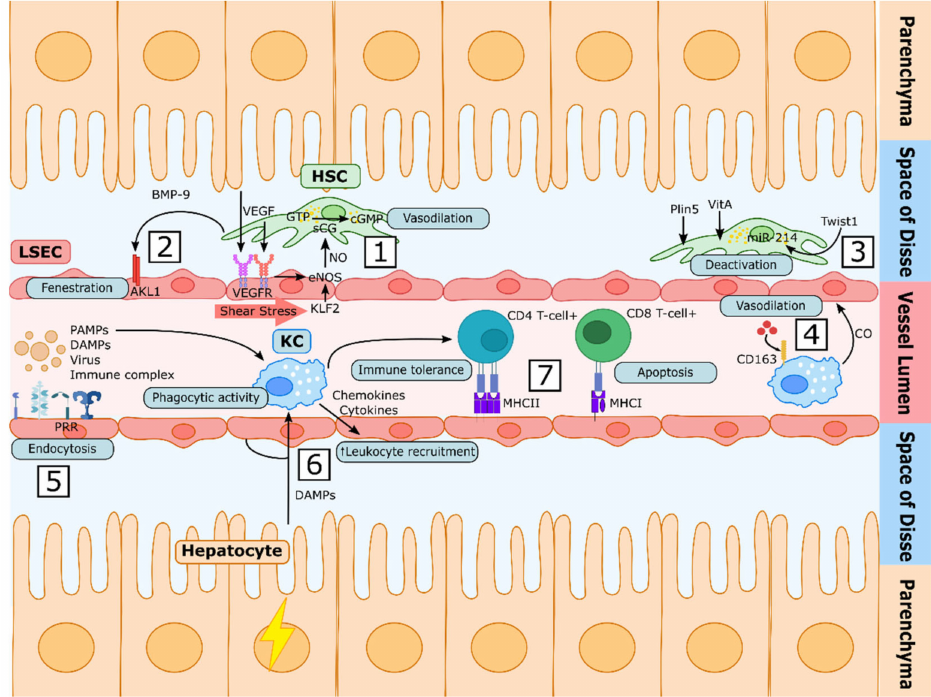
Figure 2. Liver sinusoidal cells’ communication under physiological conditions. ( 1 ) In homeostatic conditions, LSECs sense VEGF through specific receptors (VEGFR). In parallel, mechanical shear stress induces Krüppel-like factor 2 (KLF2), altogether maintaining LSECs’ vasodilatory phenotype, inducing NO synthesis. NO activates the soluble guanylate cyclase (sGC) in HSCs, leading to vasodi- lation. ( 2 ) The endothelium is fenestrated in healthy conditions. Circulating bone morphogenetic protein (BMP-9) released by HSCs contributes to the maintenance of the fenestrae by its recognition through activin receptor-like kinase 1 (ALK1). ( 3 ) Perilipin 5 (Plin5) participates in the formation of vitamin A (VitA)-containing lipid droplets. In addition, quiescent HSCs secrete exosomes containing the transcription factor Twist1, which promotes HSCs quiescence autocrinally through the transcrip- tion of miRNA-214. ( 4 ) Kupffer cells (KCs) incorporate haemoglobin through the scavenger receptor CD163 and, by its degradation, produce vasoprotective products such as carbon monoxide (CO). ( 5 ) LSECs display high-affinity receptors which participate in innate immunity, such as pattern recog- nition receptors (PRRs), being capable of sensing pathogen-associated molecular patterns (PAMPs), damage-associated molecular patterns (DAMPs), viruses and other immune complexes. ( 6 ) KCs are responsible for the phagocytosis of bacteria or particle-associated antigens. Upon damage, KCs recognize PAMPs or DAMPS and produce cytokines and chemokines which increase the expression of adhesion molecules by LSECs, leading to leukocyte infiltration and activation. ( 7 ) LSECs can act as antigen-presenting cells, as they express major histocompatibility complexes I and II (MHC-I and MHC-II). Presentation to CD4+ T cells promotes their differentiation towards T regulatory (Treg) immunosuppressive cells, enhancing tolerance. On the other hand, LSEC antigen presentation to CD8+ T cells increases the programmed death of the CD8+ T cells suppressing the immune